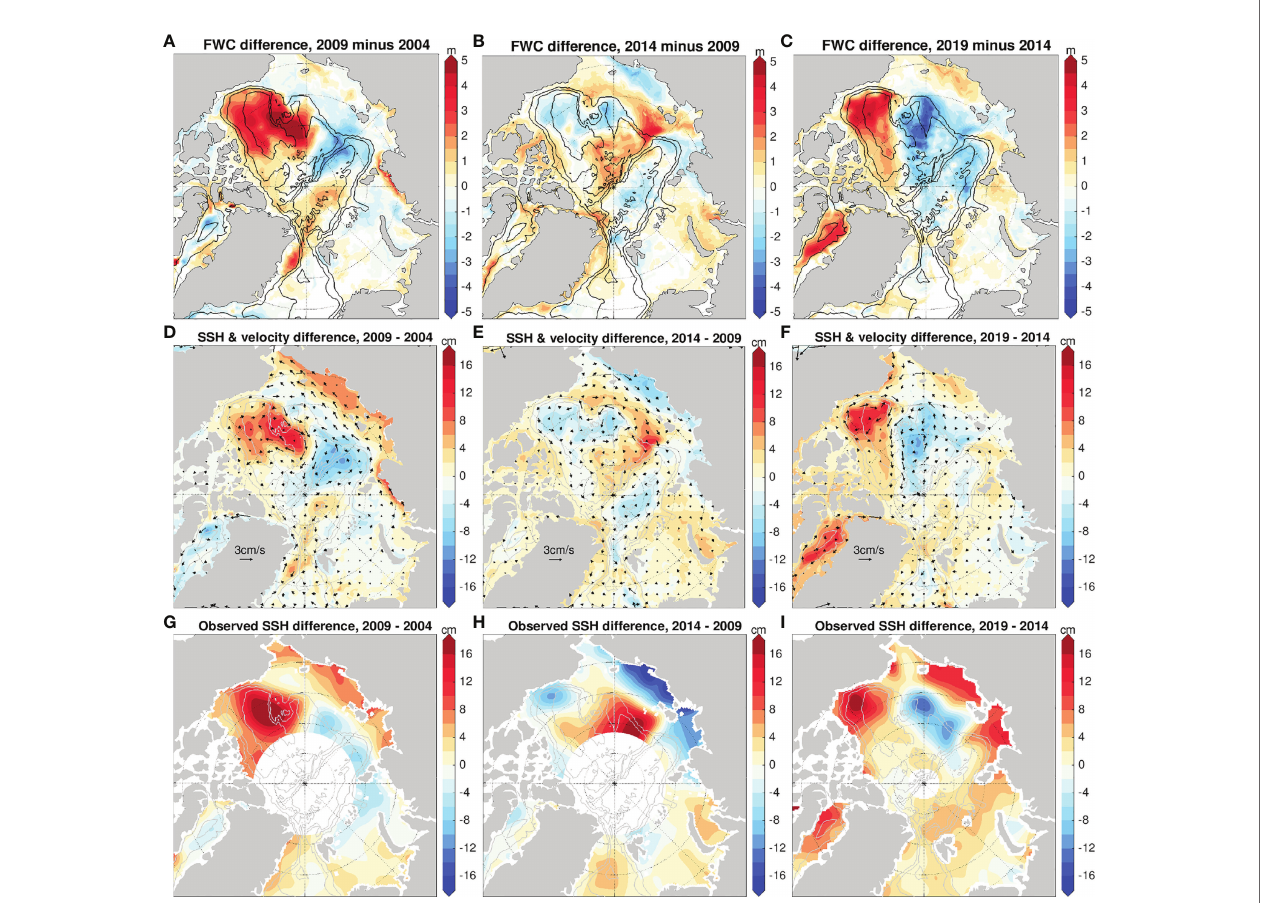
FIGURE 6 | Changes of Arctic freshwater content (FWC, m), sea surface height (SSH) and upper ocean circulation in different periods. Changes in FWC in the FESOM historical simulation: (A) between 2004 and 2009, (B) between 2009 and 2014, and (C) between 2014 and 2019. (D – F) The same as (A – C) respectively, but for SSH [color] and upper 150 m velocity [vectors]. Satellite-derived changes in SSH (Envisat and CryoSat2, Armitage et al., 2016) are shown in (G – I) for the corresponding